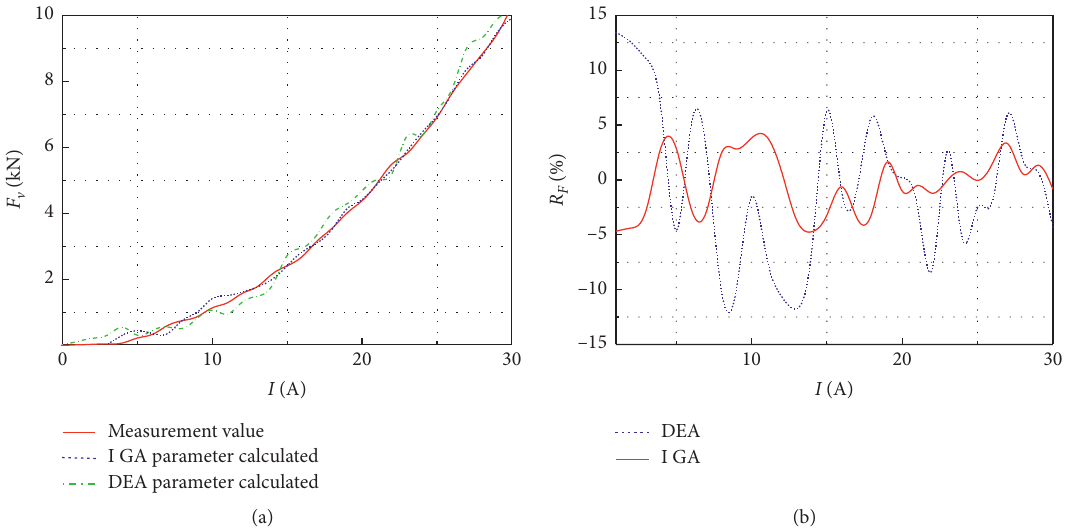
Figure 6: Excitation force and its relative error. (a) Calculated value and measured value of excitation force.(b) Relative error of excitation